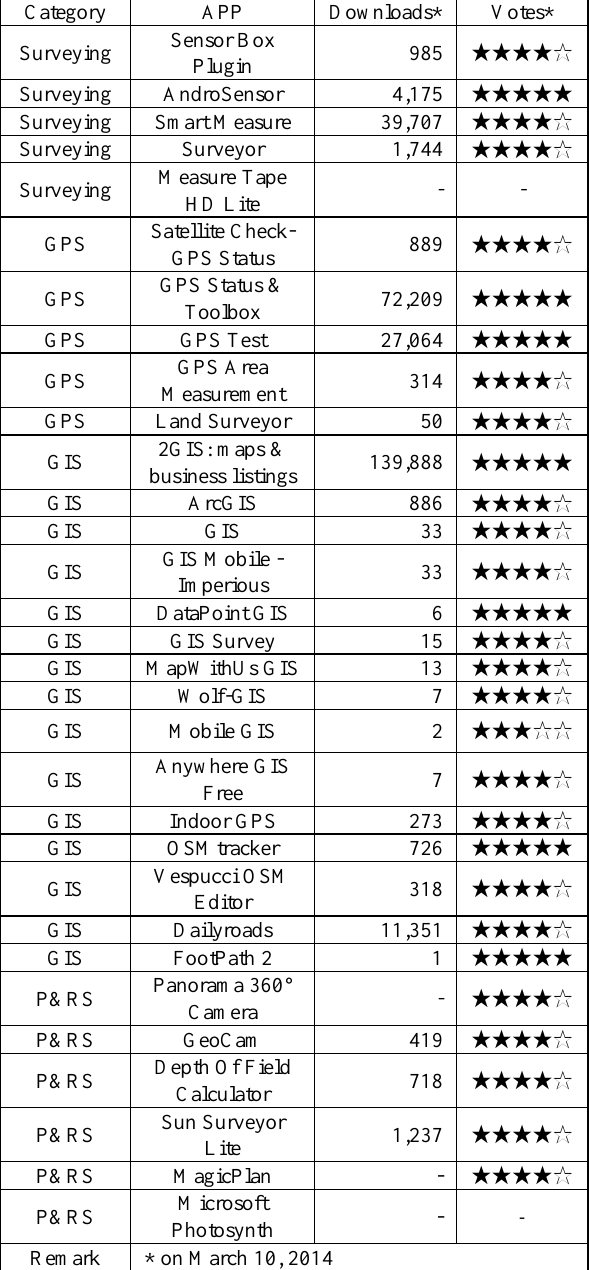
Table 2. Geomatics-related